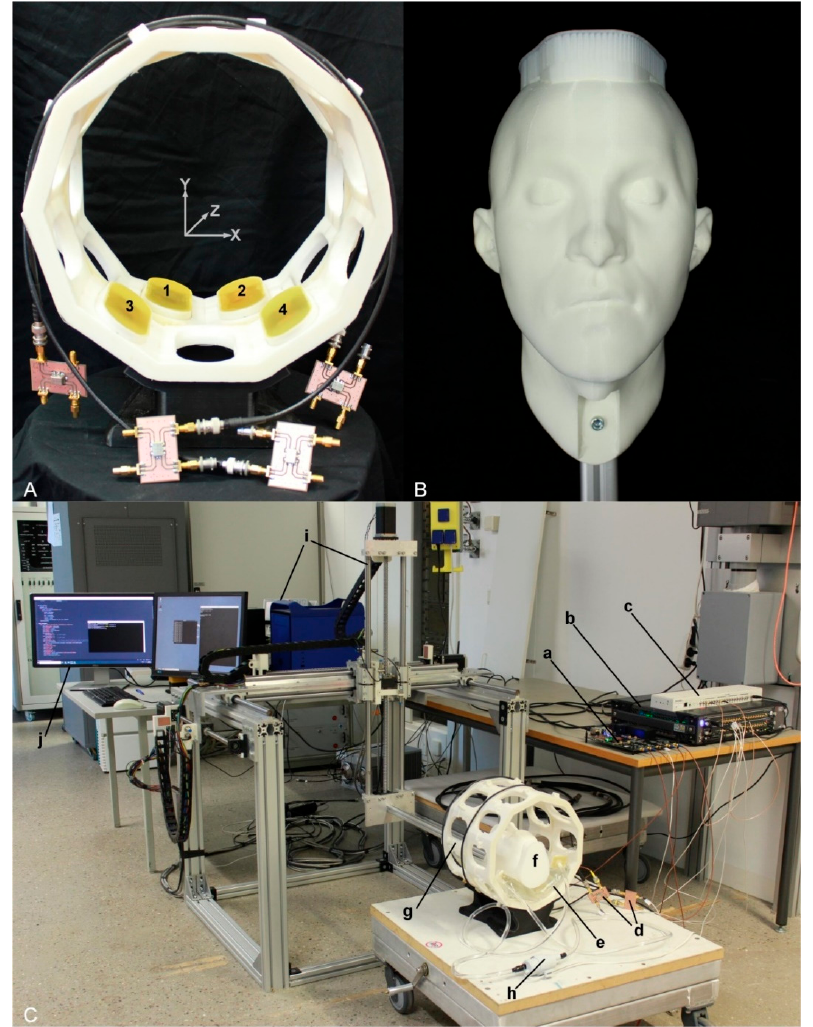
Figure 4. Experimental setup used for head motion detection. ( A ) Annular antenna holder in a two- ring arrangement (inner diameter = 24 cm) including ten antenna positions for each ring. Four SGBT antennas (two for each ring) were installed in the holder, as illustrated by the numbers 1–4. The antennas were connected to the signal generator via home-built directional couplers. ( B ) A 3D printed head model installed to an aluminum profile and used as an object under investigation. ( C ) The experimental setup, ( a ) supervision module, ( b ) custom-built RF signal generator, ( c ) clock dis- tributor, ( d ) home-built directional couplers, ( e ) water pad, ( f ) head model, ( g ) antenna holder, ( h ) water pump, ( i ) the COSI Measure setup [42], and ( j ) computer for interacting with the equipment. The obtained RF power deposition regarding both the upkeep of the therapeutic ex- posure and the sparing of the healthy tissue was assessed. The maximum local SAR 10g was evaluated in the tumor and the healthy tissue, together with the respective mean SAR 10g value. The volume power density P tumor /V tumor , being the quantity which governs the actual heating of the tissue, assesses the overall RF power deposition in the target volume. Nor- malization with the tumor volume makes it comparable across various models. The SAR amplification factor (SAF; [24]) quantifies the overall sparing of the healthy tissue by re- lating the mean exposure in the target volume to the mean exposure of the healthy tissue (SAF = SAR 10g,mean (tumor)/SAR 10g,mean (healthy)). The tumor-to-hotspot quotient (THQ; [43])